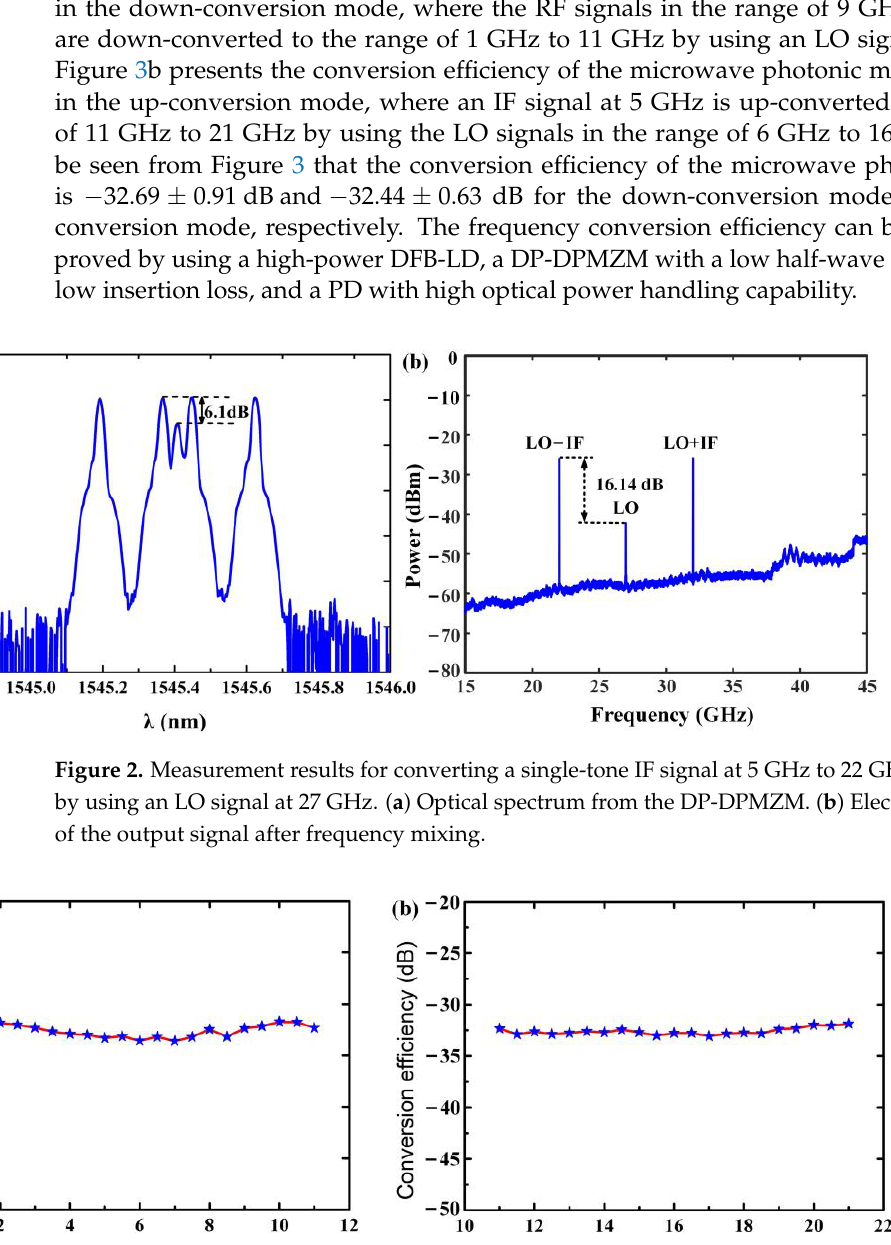
Figure 3. Conversion efficiency of the microwave photonic mixer working in ( a ) the down-conver- sion mode and ( b ) the up-conversion